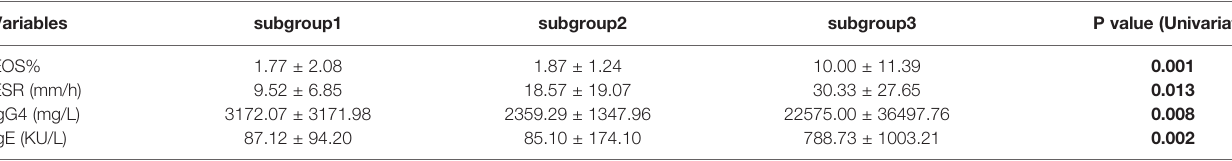
TABLE 1 | Serological biomarker levels of IgG4-RD patients in each subgroup after treatment.